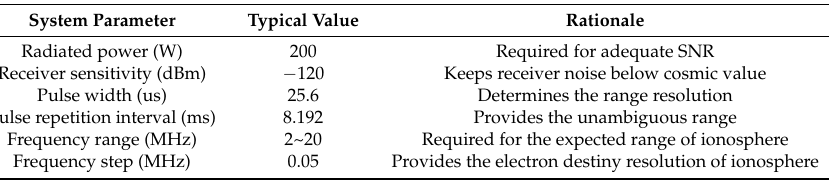
Table 3. Parameters of the emission